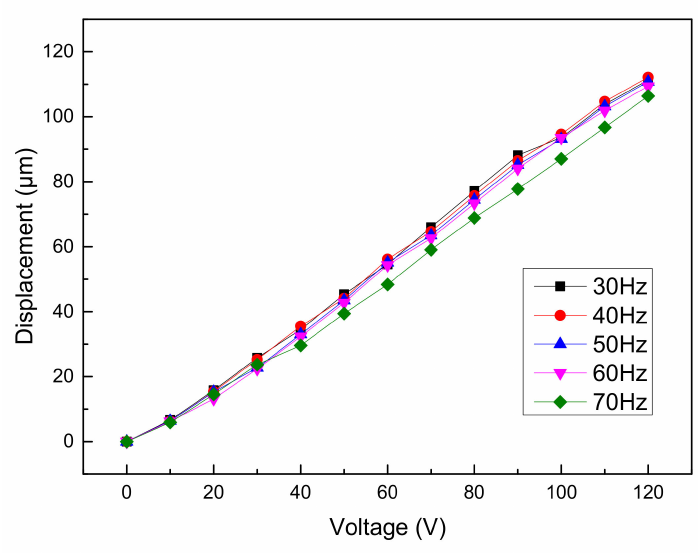
Figure 19. Displacement of the actuator versus input voltage under different